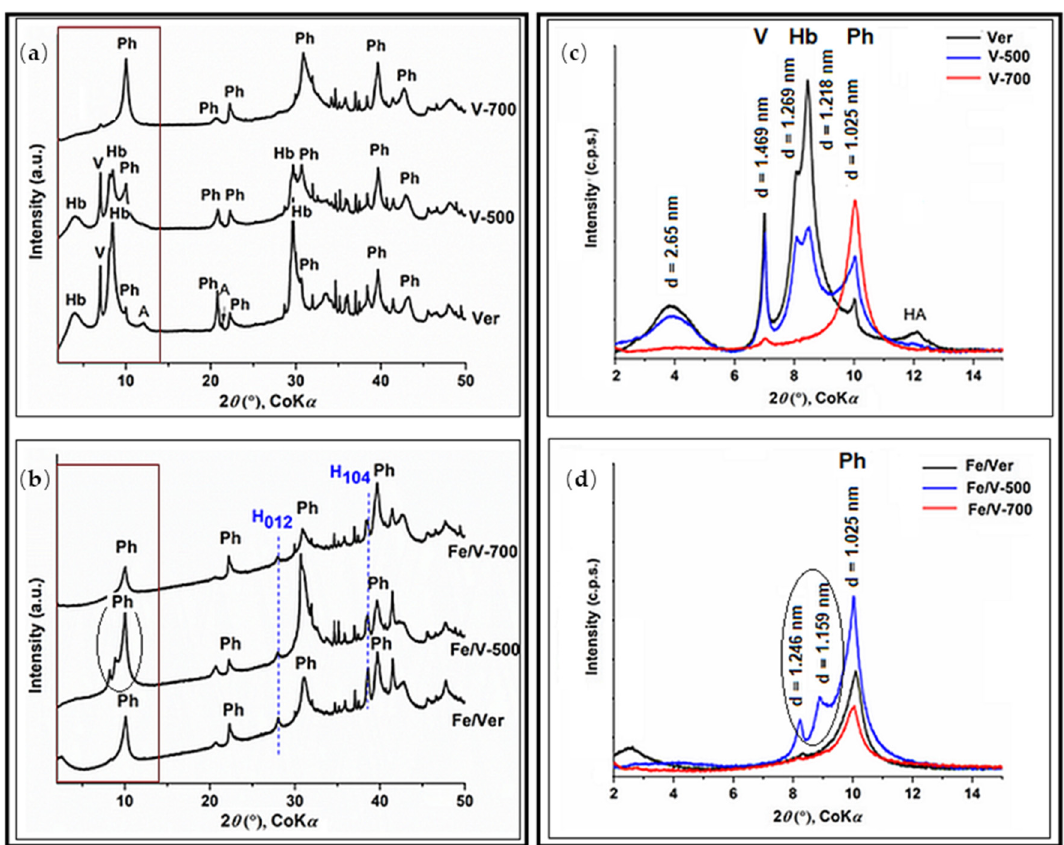
Figure 2. XRD patterns from 2 to 50° 2 θ of: ( a ) vermiculites (Ver, V–500 and V–700) and ( b ) α -Fe 2 O 3 nanoparticles/vermiculite composites (Fe/Ver, Fe/V–500 and Fe/V–700). Peaks are marked: V = vermiculite, Hb = hydrobiotite, Ph = phlogopite, H = hematite and HA = hydroxyapatite; and XRD patterns from 2 to 15° 2 θ with d-values of peaks of: ( c ) vermiculites and ( d ) α -Fe 2 O 3 /vermiculite composites.